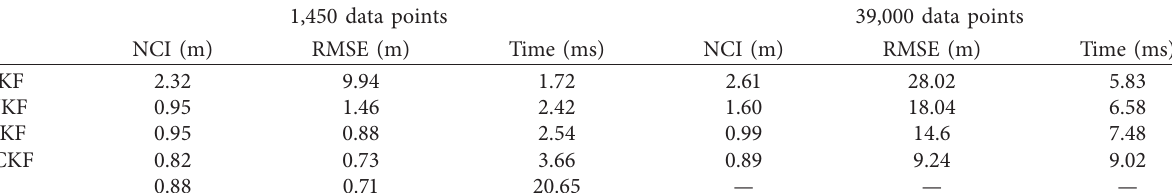
Table 4: RMSE, NCI, and time of difference